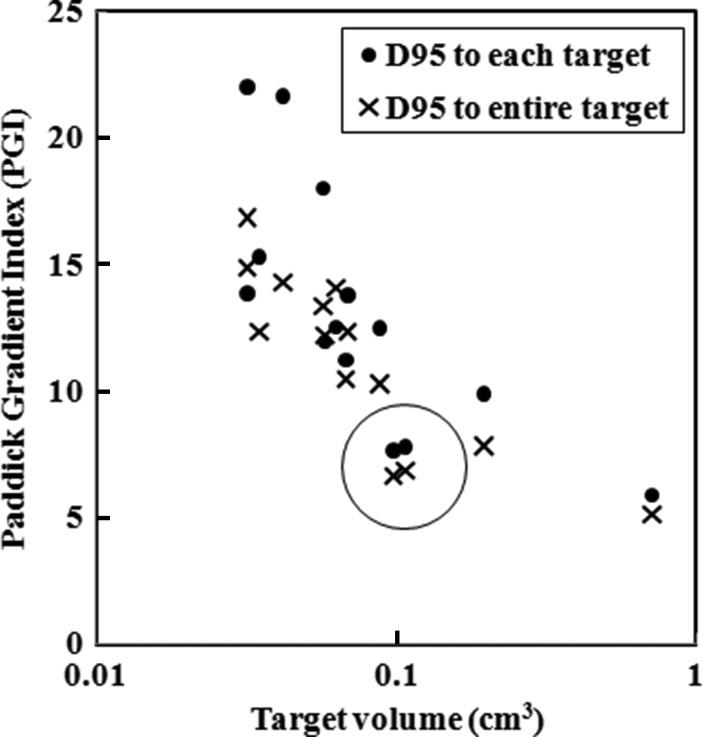
Plots of Paddick's gradient index (PGI) of the 14-mets plan as a function of the target volume, where D95 was prescribed for each of the PTVs (marked with filled circles) and to the entire PTVs (marked with X's). Again, PGIs for two targets were significantly lower than others (marked with open circle), possibly resulting from an exceptionally short distance between the two targets (1 cm).